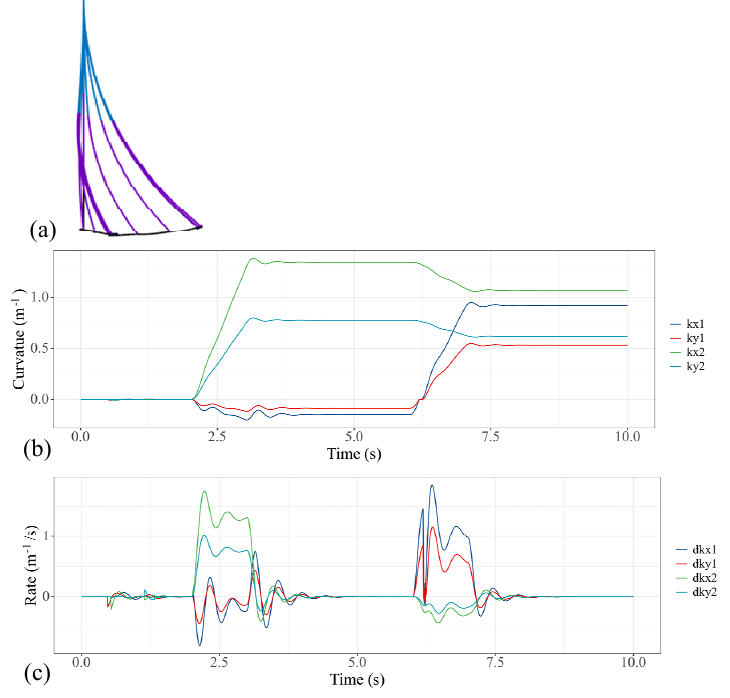
Figure 8. Simulation results of the soft manipulator when the first, fifth and sixth actuators are actuated by ramp torque. ( a ) Soft manipulator trajectory versus time. ( b ) Curves of the bending curvature versus time. ( c ) Curves of speed versus